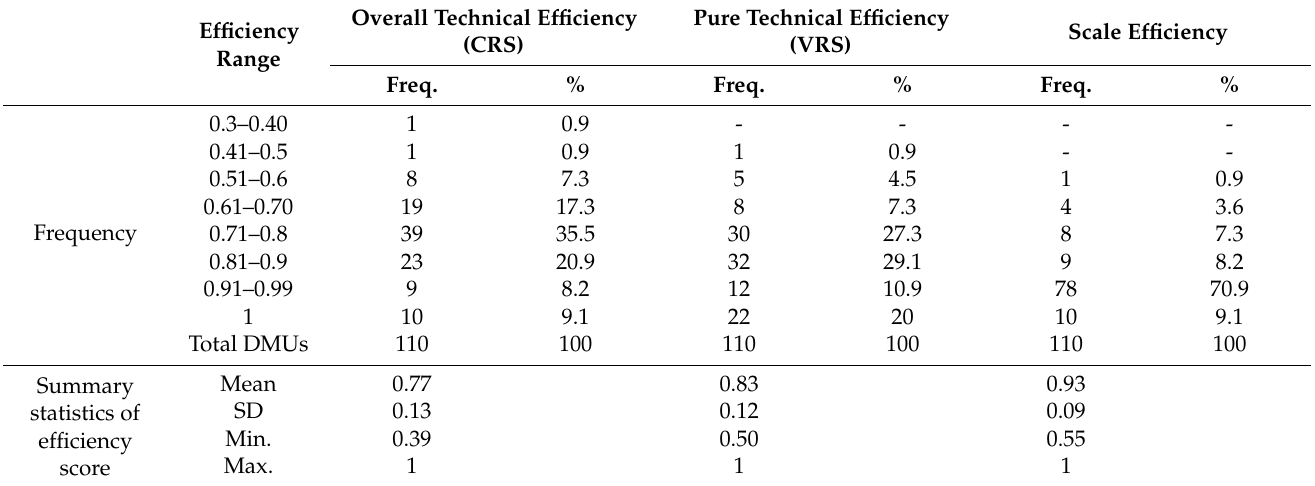
Table 3. Frequency distributions of technical and scale efficiencies of the saffron